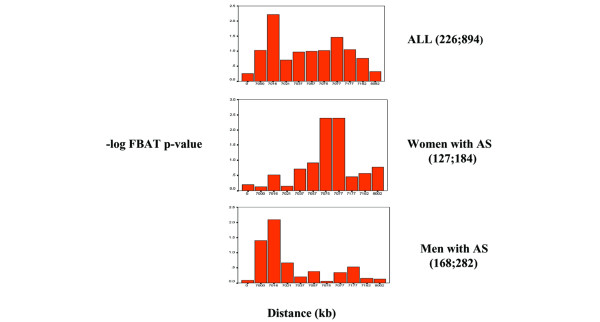
A summary of family-based association analyses (FBAT; additive model and biallelic tests). Each column in the charts represents the -log FBAT P value for each marker located at a distance relative to one another. D5S1953 is positioned at 0 distance. Chart ALL shows analysis of 226 ankylosing spondylitis (AS) nuclear families with 894 persons. Chart Women shows analysis of 127 AS families with 184 affected women. Chart Men shows analysis of 168 AS families with 282 affected men.